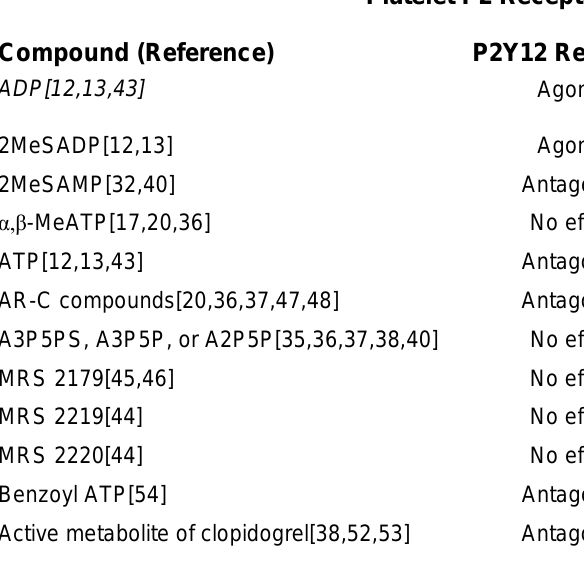
Platelet P2 Receptor